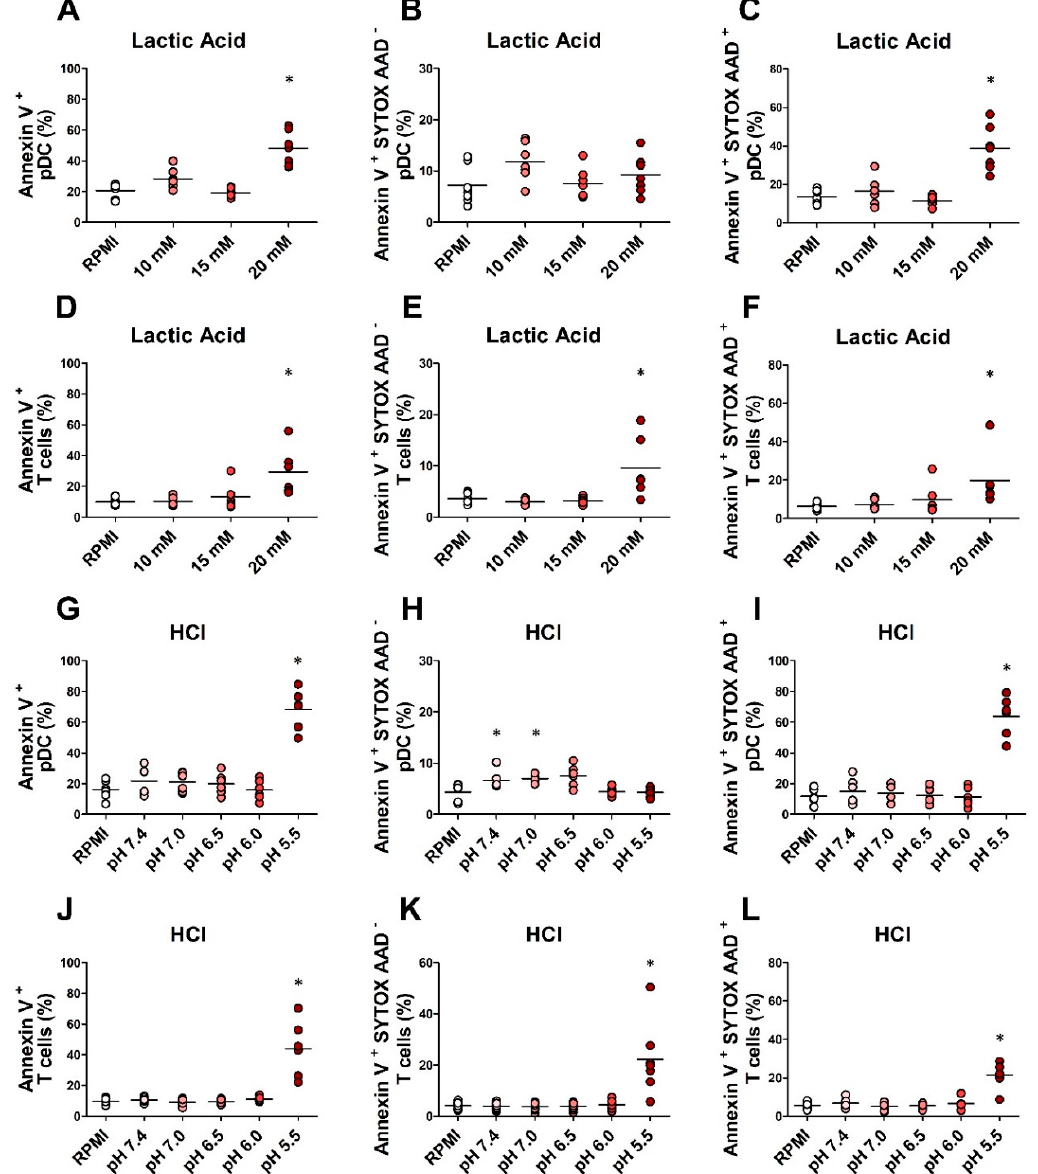
Figure 3. Lactic acidosis affects the viability of pDCs and T cells. pDCs and T cells purified from buffy coats of HD were cultured in RPMI 1640 medium supplemented with 10% FBS plus lactic Acid (10 mM; 15 mM; 20 mM) ( n = 7 ( A – C ); n = 6, ( D – F )) or hydrochloric acid (pH = 7.4; 7.0; 6.5; 6.0; 5.5 ( n = 6 ( G – I ); n = 7, ( J – L )) for 24 h. IL-3 was added to pDCs’ culture. The cellular viability was analyzed by annexin V / SYTOX AADvanced staining in flow cytometry. Aligned dot plot graphs show the percentages of dead ( A , D , G , J ), early apoptotic ( B , E , H , K ), and late apoptotic or necrotic cells ( C , F , I , L ). Bars represent the mean of biological replicates. The statistical significance was calculated by two-sample paired sign test. * p < 0.05.